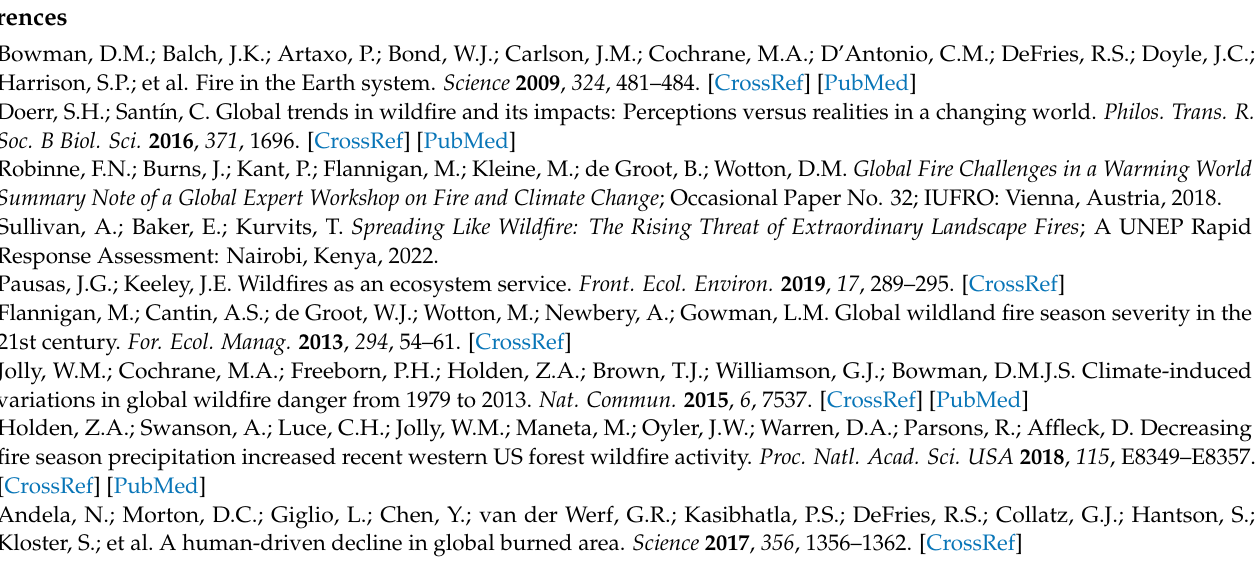
Figure A1. Monthly lightning strikes over Sweden between 2012 and 2019.